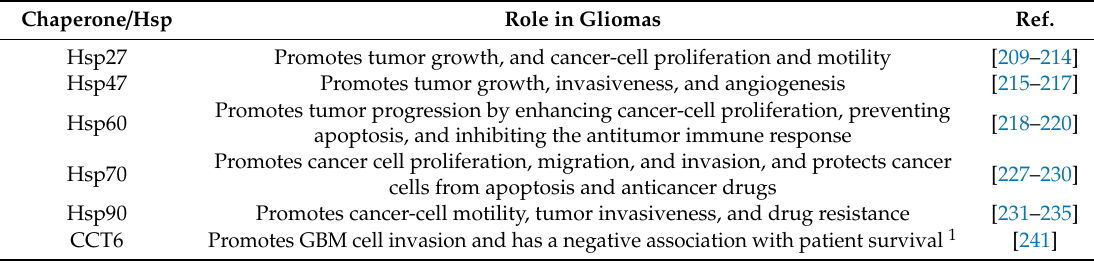
Table 3. Reported roles of Hsp27, Hsp47, Hsp60, Hsp70, and Hsp90 in gliomas. Chaperone /